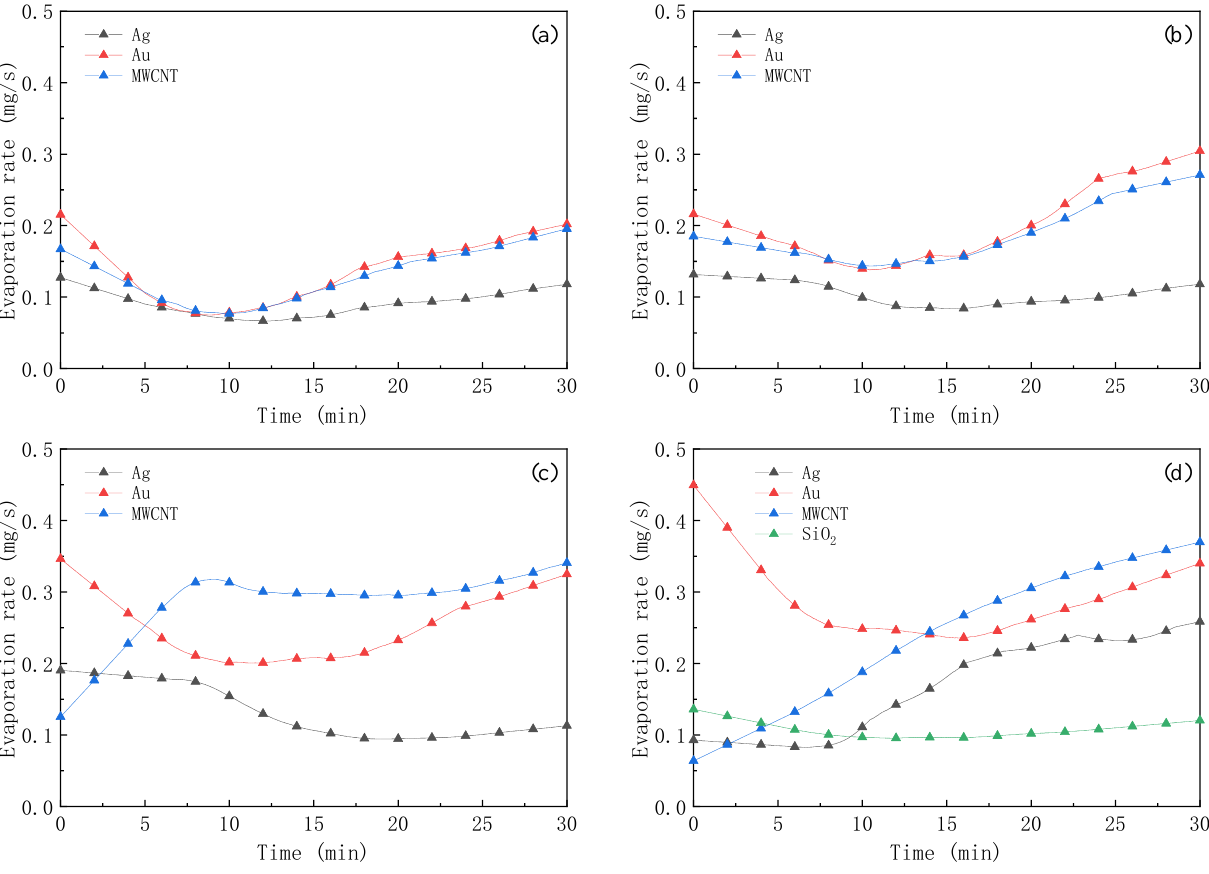
Figure 11. Evaporation rate of Ag, Au, MWCNT, and SiO 2 nanofluids in 30 min of illumination ( a ) 50 ppm; ( b ) 200 ppm; ( c ) 500 ppm; ( d ) 1000 ppm.